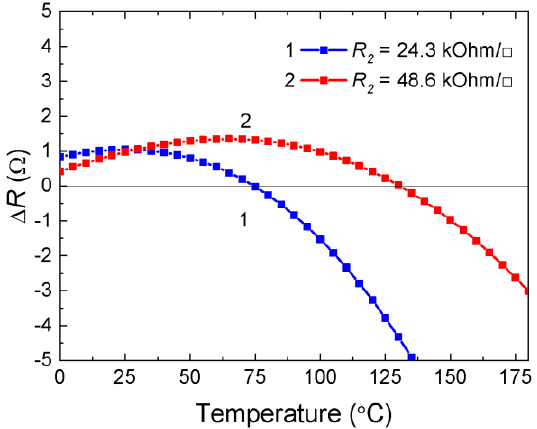
Figure 10. Calculated dependence of the temperature change in the resistance of a two-layer system according to criteria (6) and (9).